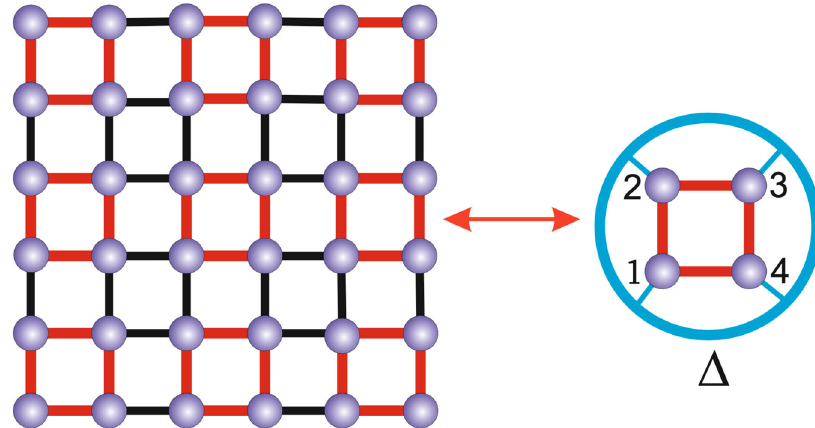
Fig. 7 Plaquette lattice. Schematic representation of a plaquette reference system for the square